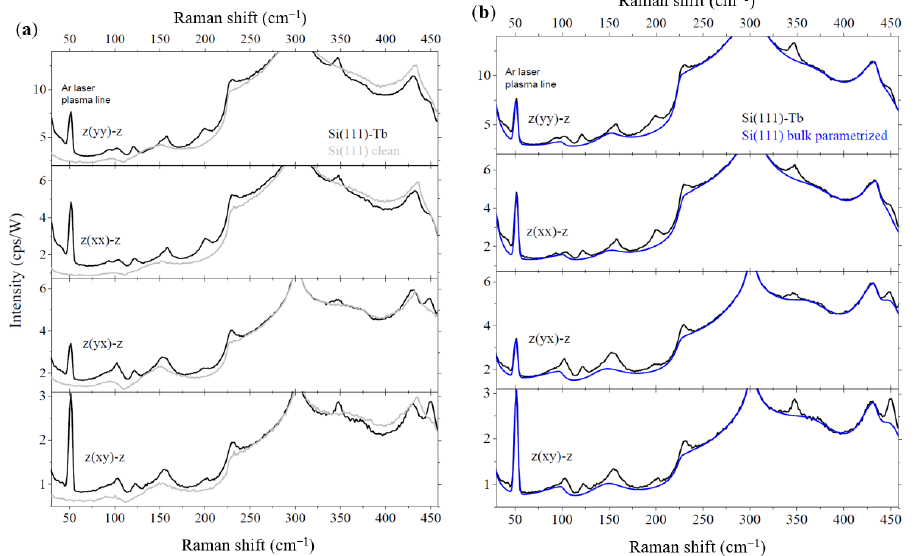
Figure A2. Measured Raman spectra of terbium silicide layer grown on 4 ◦ -offcut Si(111) substrate (black) are compared with ( a ) the measured spectra of the clean Si(111) surface (grey) and ( b ) the parametrized spectra of bulk Si(111) (blue). The Ar laser plasma line at 50cm − 1 , visible due to misalignment of the bandpass filter, was included in the parametrization of the